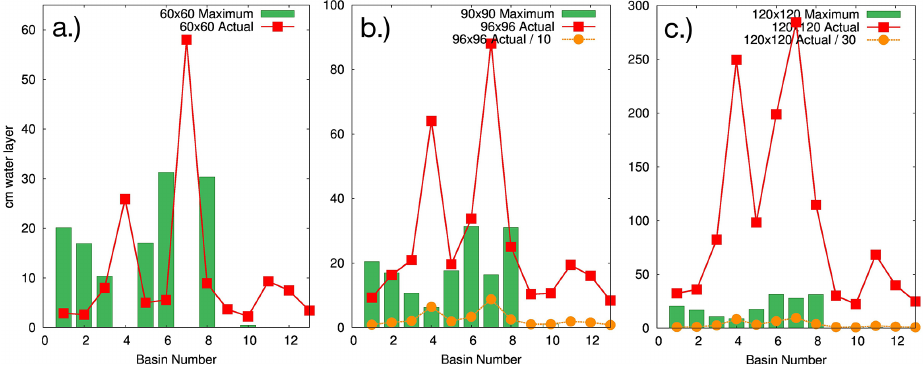
Figure 11. Comparison of maximum allowed stripes (green boxes) based on SNR >2, and the actual estimated stripes per basin (red lines) for the (a) 60 × 60, (b) 90 × 90, and (c) 120 × 120 cases. For (b) , the actual stripe signal is from the 96 × 96 GRACE runs. The orange dashed lines denote the actual stripes reduced by the factors of 3.5, 9, and 30, as needed to fall within the allowed values. All figures use yearly windowed